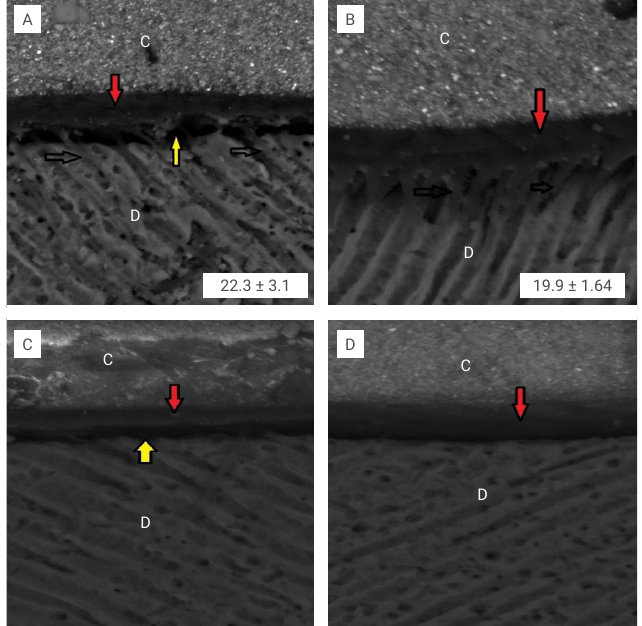
Figure 3. SEM image 3000X showing tooth/restoration interface after one year water storage, (A) Scotchbond Universal etch-and-rinse mode; (B) All Bond Universal etch-and-rinse mode; (C) Scotchbond Universal self-etch mode; (D) All Bond Universal self-etch mode (D) dentin; (C) composite; Red arrows marking the hybrid layer; White arrows marking the resin tags; yellow arrows marking gaps, rectangle: mean length(µm) of resin tags ± standard